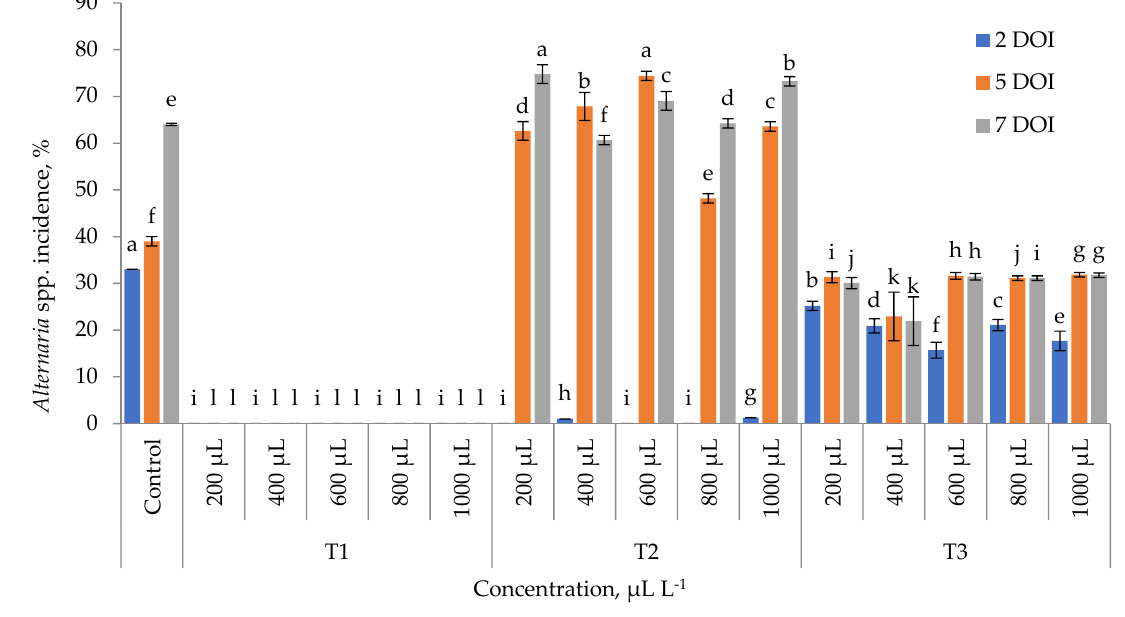
Figure 2. The incidence of Alternaria spp. on carrot seeds under the influence of thyme (T1), hyssop (T2), and common juniper (T3) essential oils treatments after 2, 5, and 7 days of incubation (DOI); according to Duncan’s multiple range test ( p < 0.05), the same letters demonstrate no significant differences between treatments at 2, 5, and 7 DOI.